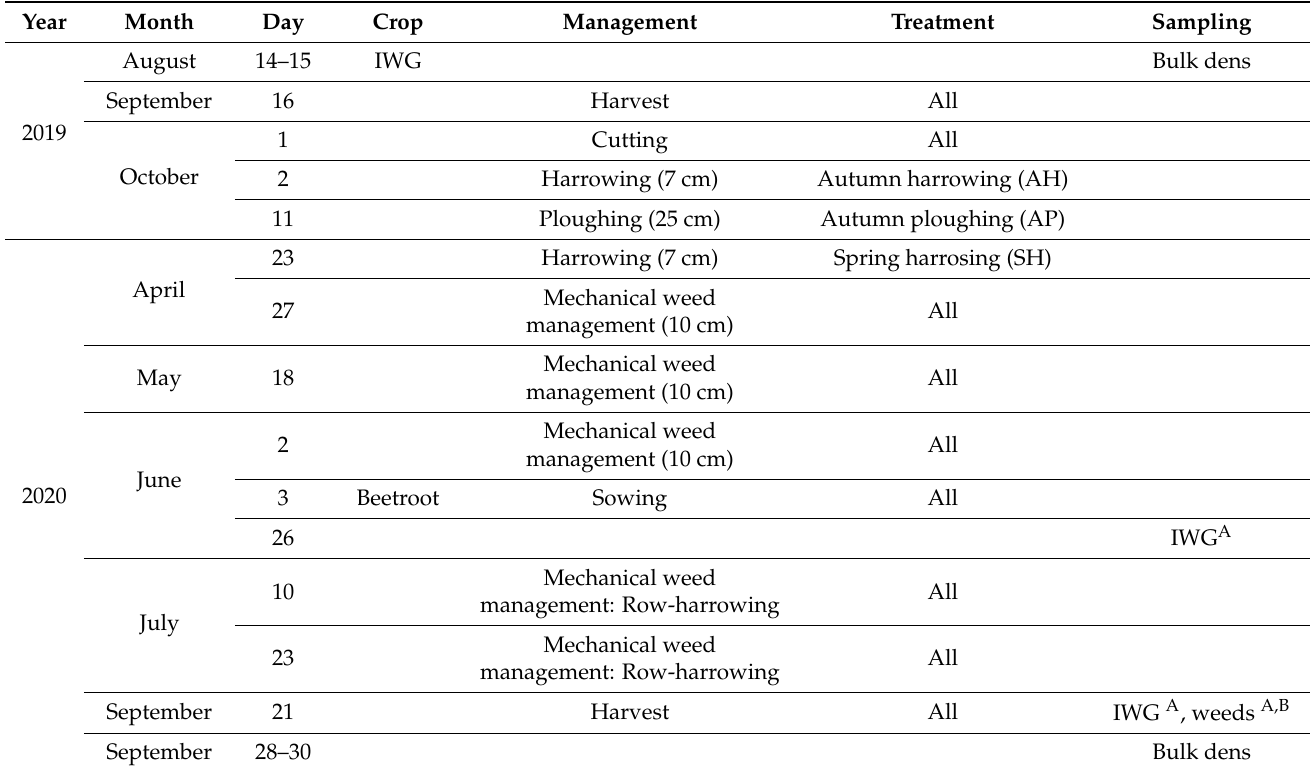
Table 1. Overview of the dates for the management, treatments and sampling in the pilot project. count and B = biomass sampling.